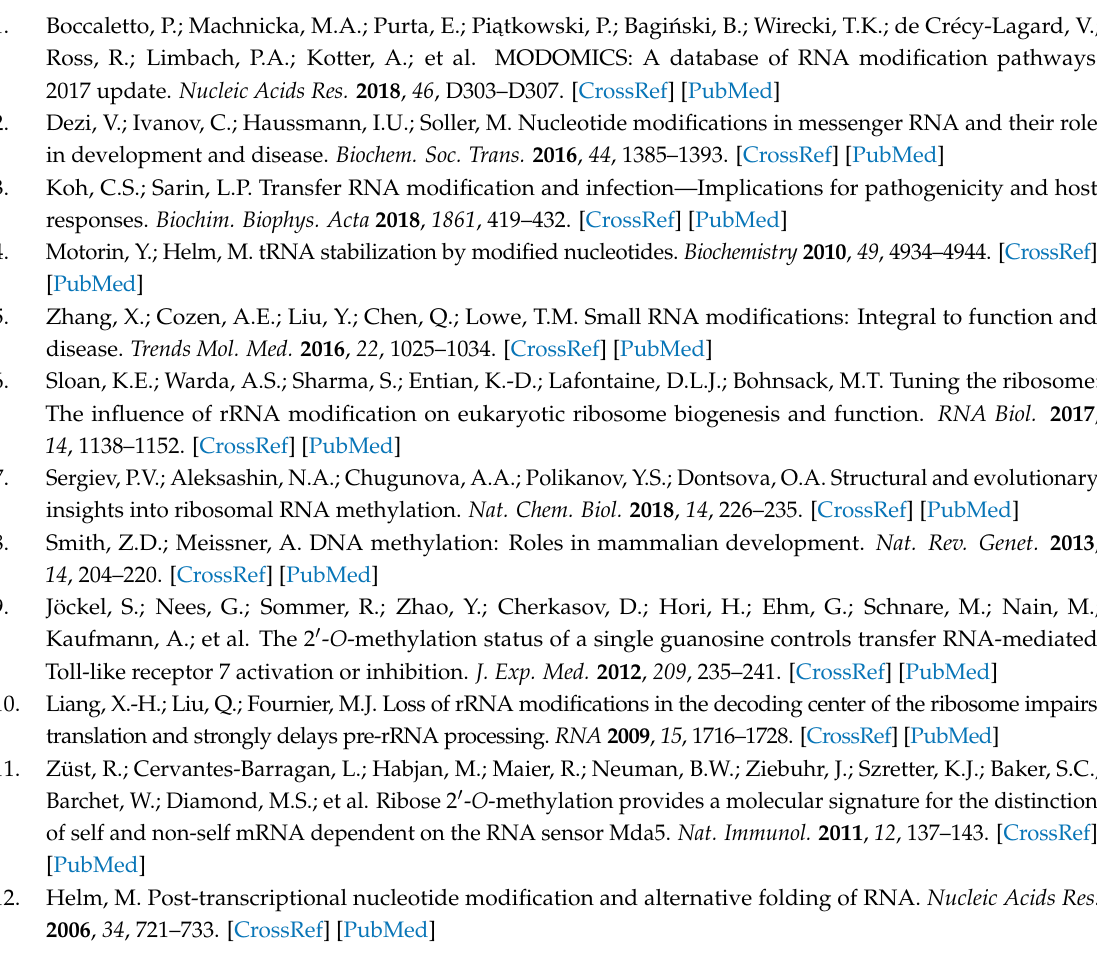
Figure S1: Evolutionary relationships of aldolases, Figure S2: SDS-PAGE of recombinant 6 × His-tagged RK9NH